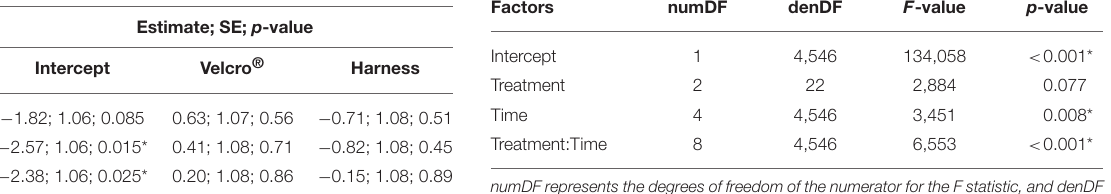
TABLE 2 | The generalized linear mixed model with a binomial error and logit link function results for the proportion of time spent below 15 cm in relation to the interaction of treatment and time.